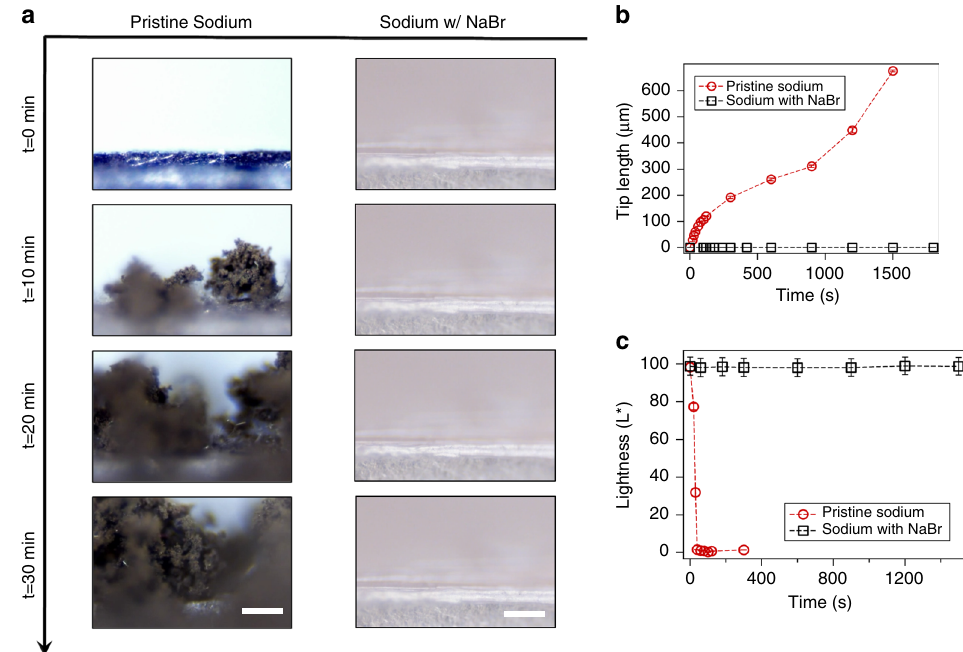
Fig. 5 Visualization of sodium electrodeposition. a Snapshots from video microscopy of the pristine Na- ( left column) and NaBr-coated Na- ( right column) electrolyte interface at 0, 10, 20 and 30 min ( top to bottom ) after onset of Na deposition at J = 1 mA cm − 2 ; scale bar , 100 µ m. b Na dendrite tip length as a function of time. c Relative brightness (L*) of electrolyte near the electrode-electrolyte interface as a function of time. This variable captures the obvious darkening of the Na deposits in the pristine case and the complete absence of this effect for the NaBr-coated electrodes. In parts ( b , c ), the error bars represent the standard deviation of measurements taken at different points in the same